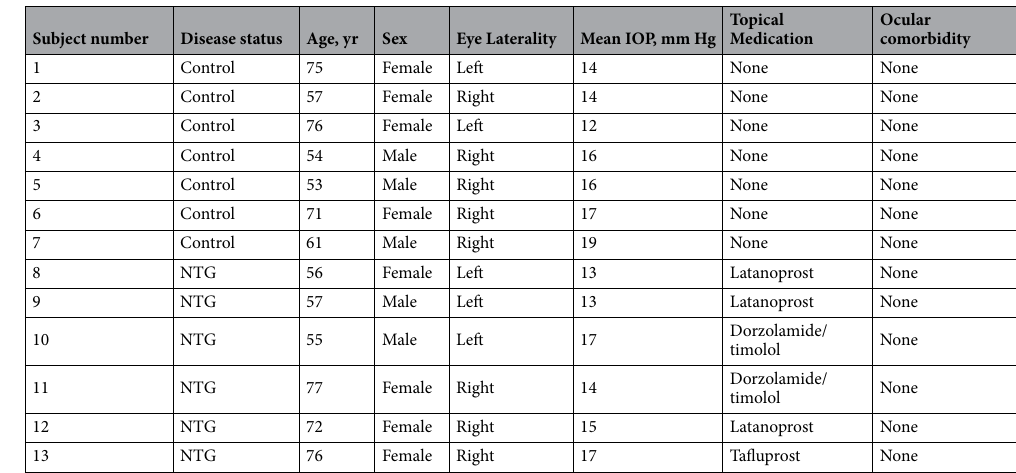
Table 1. Baseline characteristics and demographics of subjects. IOP intraocular pressure, NTG normal- tension